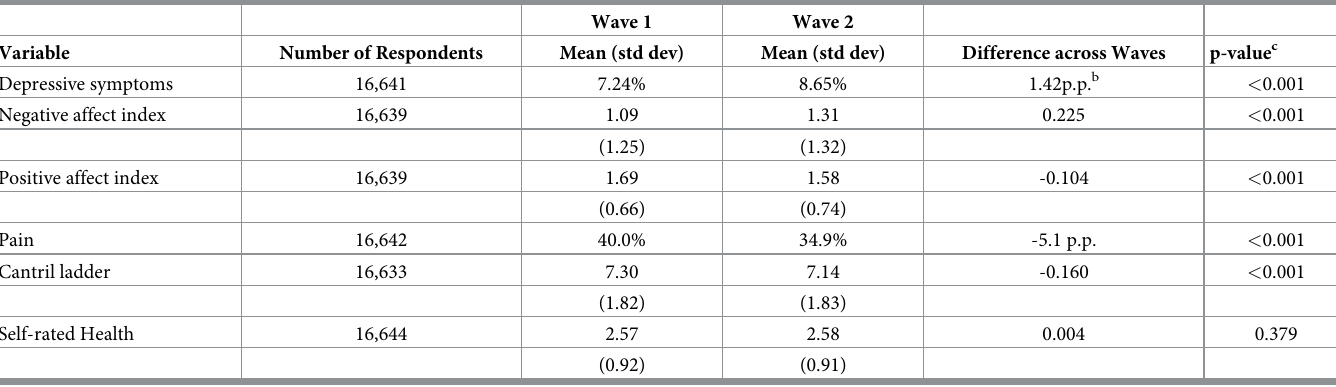
Table 2. Measures of well-being across survey waves 1 and 2 a